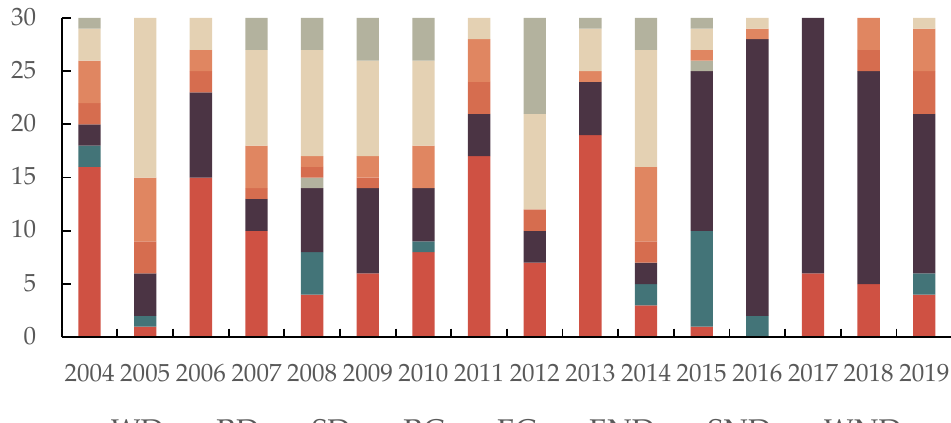
Figure 7. Distribution of the provinces in different decoupling status during the study